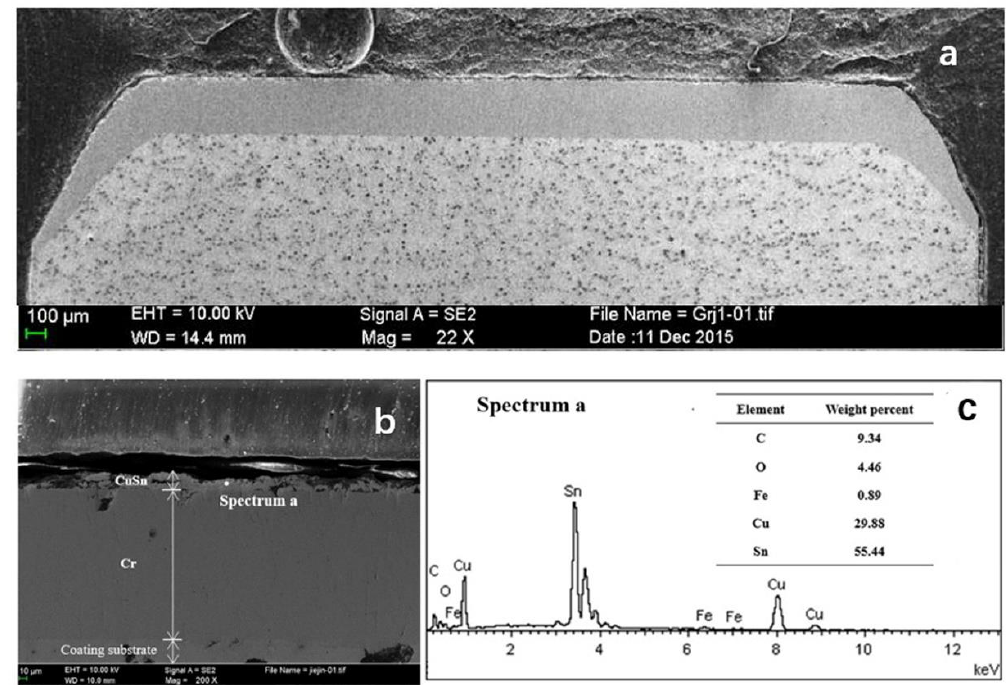
Figure 1. Structural profile ( a ), cross-section topography ( b ) and elemental contents ( c ) of the CuSn-Cr coated piston ring.